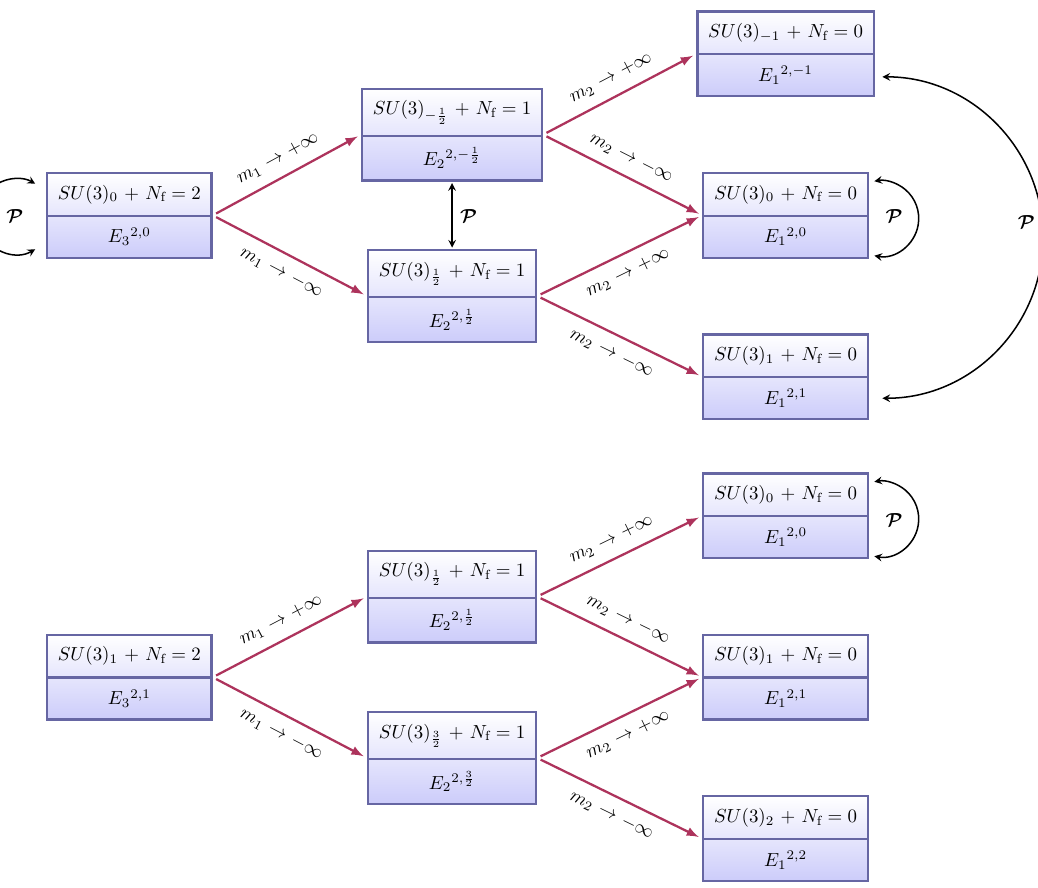
Figure 1 . RG (cid:13)ows connecting the di(cid:11)erent rank-two toric singularities discussed in this paper, the corresponding gauge-theory phases, and their relations under parity (denoted by ). Non- P gauge-theoretic phases are not shown in the (cid:12)gure, but do arise as discussed in the main text. Top: rank-two theories stemming from the E 32 ; 0 (\beetle") singularity. Bottom: rank-two theories stemming from the E 32 ; 1 singularity. There is a -transformed version of this (cid:13)ow, which is not P shown